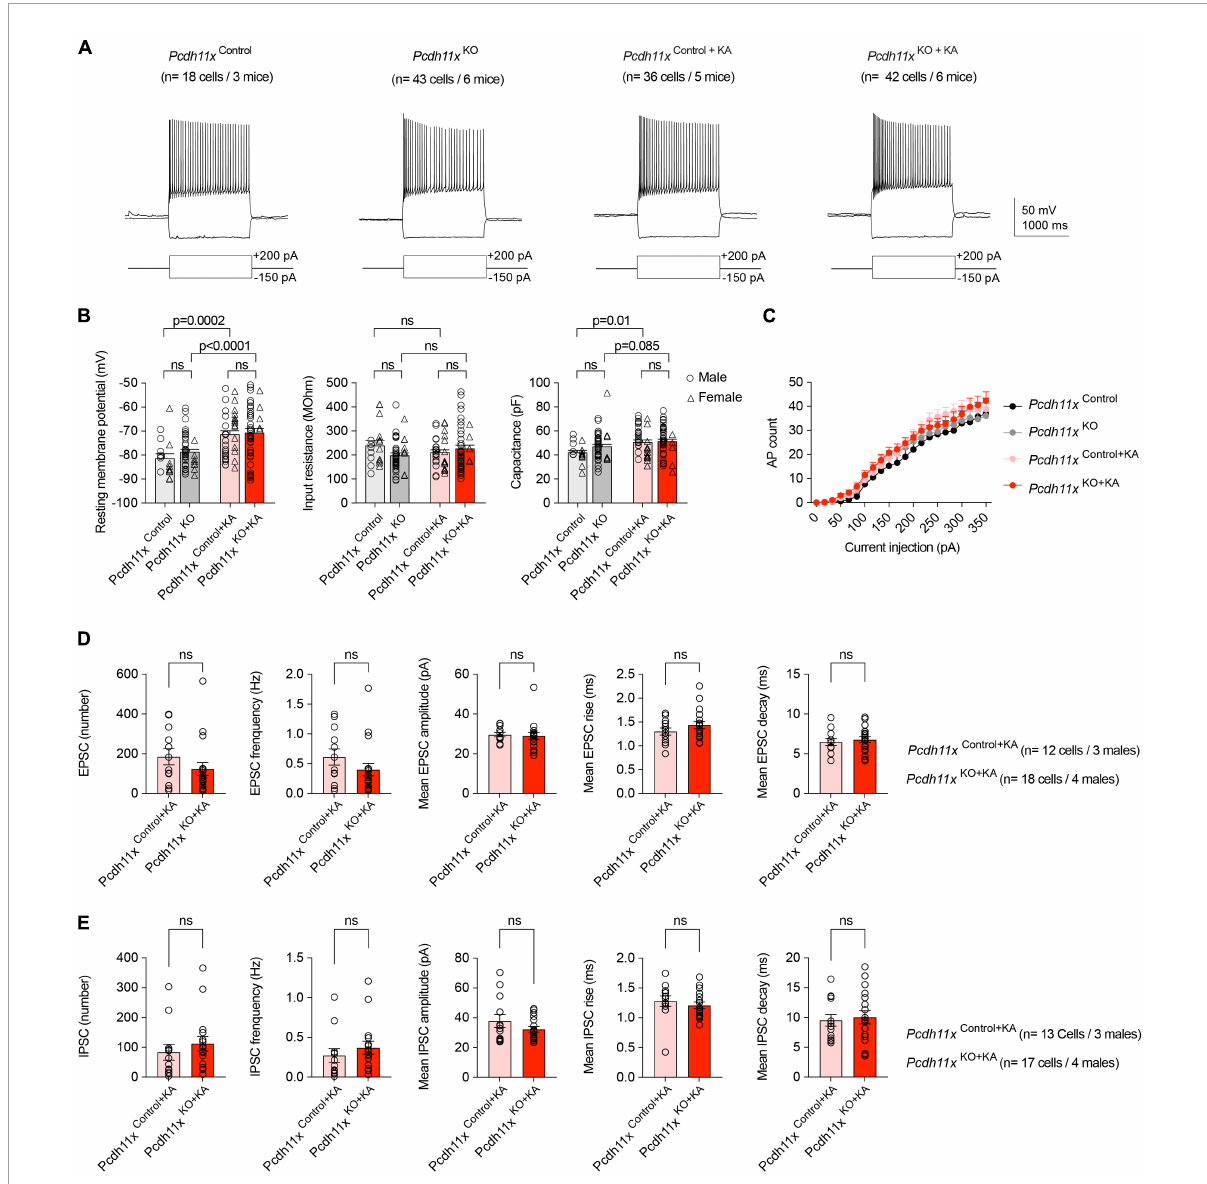
FIGURE5 Electrophysiological characterization of Pcdh11x Control + KA and Pcdh11x KO + KA GCs. (A) Example electrophysiological traces show responses to 1.5 s long current pulse injections in Pcdh11x Control , Pcdh11x KO , Pcdh11x Control + KA , and Pcdh11x KO + KA GCs. (B) Quantification of resting membrane potential, input resistance, and capacitance (two-way ANOVA tests; resting membrane potential: F KAtreatment (1,135) = 30, p < 0.0001; F KO (1, 135) = 1.1, p = 0.30; F KAtreatmentxKO (1,135) = 0.35, p = 0.56; input resistance: F KAtreatment (1,135) = 0.0009, p = 0.98; F KO (1, 135) = 0.92, p = 0.33; F KAtreatmentxKO (1,135) = 4.3, p = 0.04; capacitance: F KAtreatment (1,135) = 9.8, p = 0.0022; F KO (1, 135) = 1.8, p = 0.18; F KAtreatmentxKO (1,135) = 1.1, p = 0.30; p -values of post hoc analyses are indicated in the figure; data points represent single cells). (C) Quantification of steady-state current injection-evoked action potential (AP) counts. (D) Quantification of EPSC parameters recorded from Pcdh11x Control + KA and Pcdh11x KO + KA GCs (Mann–Whitney U test; data points represent single cells recorded from males). (E) Quantification of IPSC parameters recorded from Pcdh11x Control + KA and Pcdh11x KO + KA GCs (Mann-Whitney U test; data points represent single cells